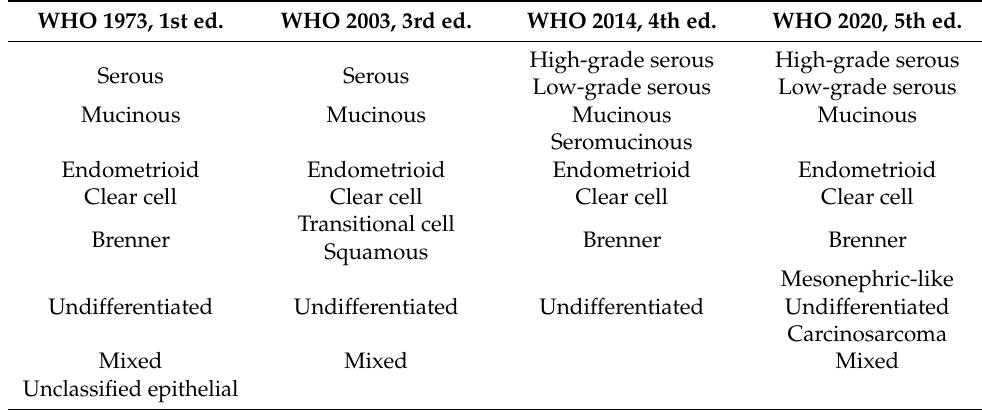
Table 1. Evolution of ovarian carcinoma histotypes in selected WHO Classifications of Female Genital